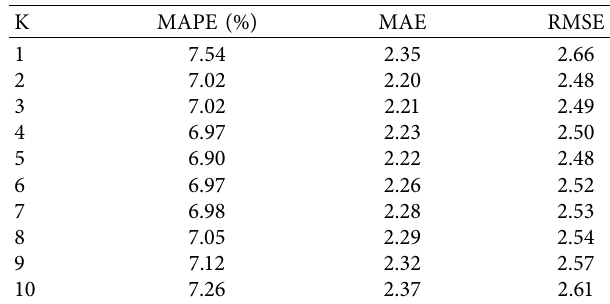
Figure 6: Optimal K given the lag duration is 20 min. Table 4: Mean absolute percentage error (MAPE), mean absolute error (MAE), and root mean square error (RMSE) according to K values when lag duration is 20